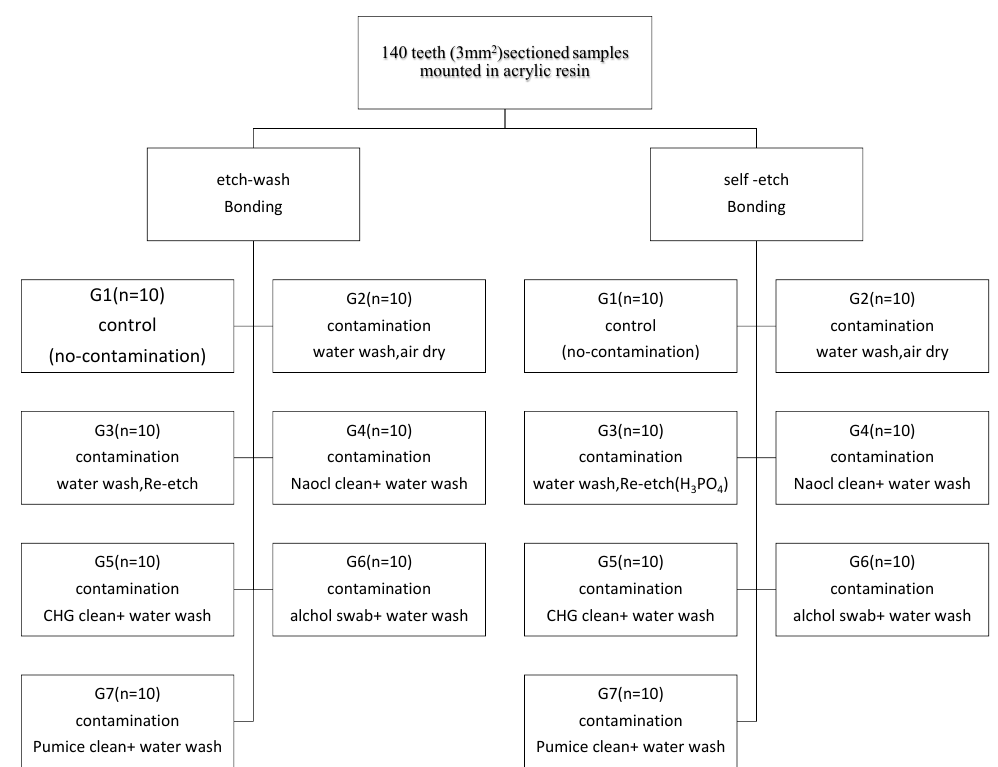
Figure 2. Flowchart of the method: Sample distribution.